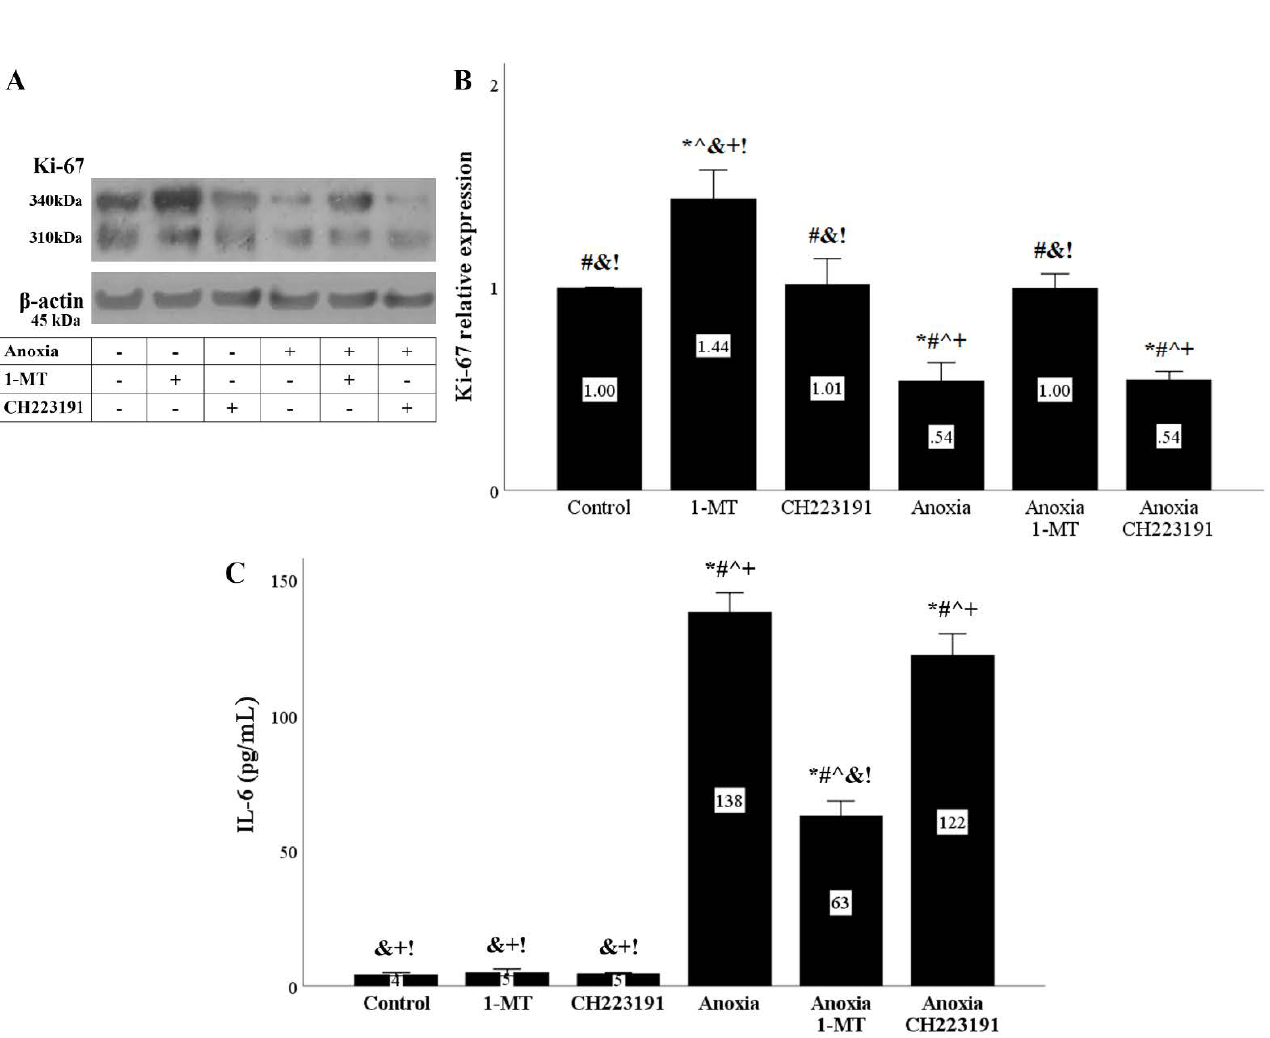
Figure 10. Anoxia inhibits cell proliferation and induces IL-6 production in an IDO dependent manner. Cells were cultured under anoxic conditions for 24 h along with the indicating treatments. Anoxia decreased the levels of the cell proliferation marker Ki-67. The IDO inhibitor 1-MT restored Ki-67 levels, whereas the AhR inhibitor CH223191 left Ki-67 levels unaffected. A representative Western blot experiment is displayed in panel ( A ), whereas panel ( B ) depicts the cumulative results of four repeated experiments. Anoxia increased IL-6 concentration in the RPTECs culture supernatants. 1-MT decreased the anoxia-induced IL-6 production, whereas CH223191 did not affect IL-6 levels ( C ). Six such experiments were performed. * p < 0.05 vs. Control, # p < 0.05 vs. Control with 1-MT, ˆ p < 0.05 vs. Control with CH223191, & p < 0.05 vs. Anoxia, + p < 0.05 vs. Anoxia with 1-MT, ! p < 0.05 vs. Anoxia with CH223191. Error bars correspond to SEM. 1-MT, 1-DL-methyltryptophan; IL-6, interleukin-6.